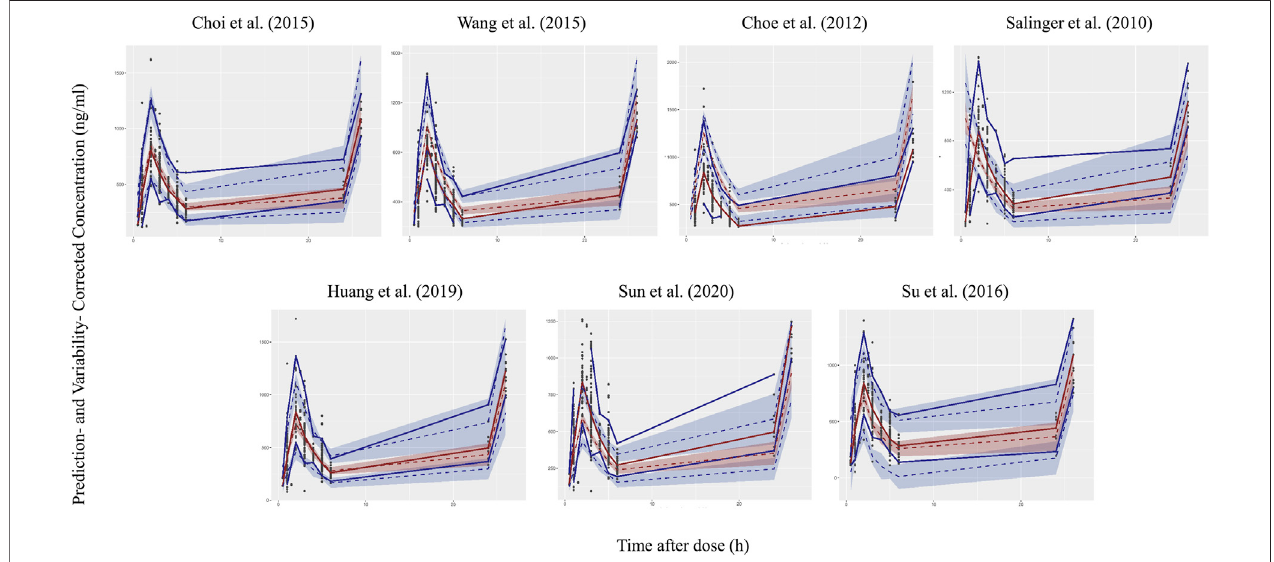
FIGURE 1 | Prediction- and variability-corrected visual predictive check (pvcVPC) plots of seven published population pharmacokinetic models (Salinger et al., 2010; Choe et al., 2012; Choi et al., 2015; Wang et al., 2015; Su et al., 2016; Huang et al., 2019; Sun et al., 2020). The middle dashed line represents the median prediction-andvariability-correctedpredictions.Themiddlesemitransparent fi eldrepresents asimulation-based95%con fi denceinterval(CI)forthemedian.Upperand lowerdashlinesrepresentthecorrectedobserved95thand fi fthpercentilesandsemitransparent fi eldsrepresentasimulation-based95%CIforthecorresponding model predicted percentiles. The solid lines represent the median, 95th and 5th percentiles of observations.